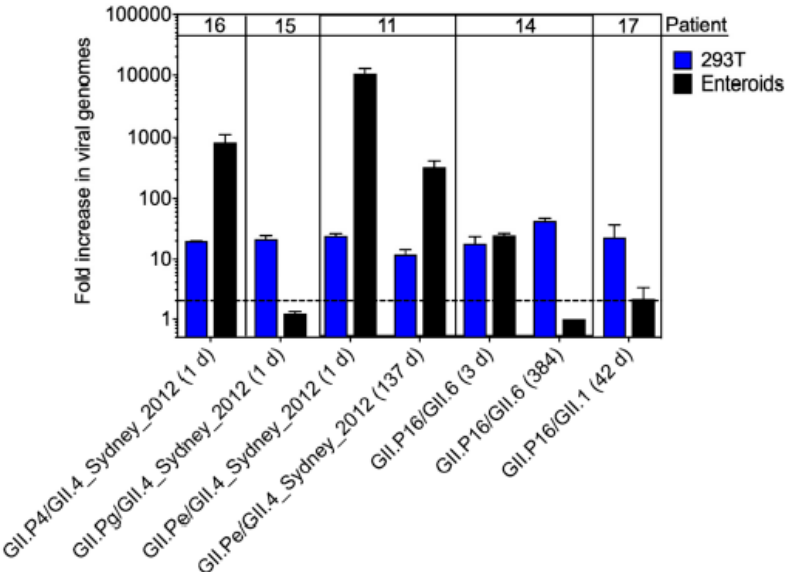
Figure 6. Human norovirus in stool samples from chronic shedders is infectious in human intestinal enteroids. 2D fetal ileum enteroids were differentiated for 6 days and then infected with unfiltered human norovirus-positive stools for 3 days. Viral genome copy numbers were measured at 0 and 3 dpi by RT-qPCR. Each sample was tested in triplicate and the entire experiment repeated twice. The fold-increase in viral titer was determined by comparing genome titers at 3 to 0 dpi. Replication data in HEK293T cells for each stool sample tested in enteroids are shown for comparison. The dashed line represents the lower limit of detection. Values for technical replicates were averaged and error bars indicate the mean of experimental repeats.